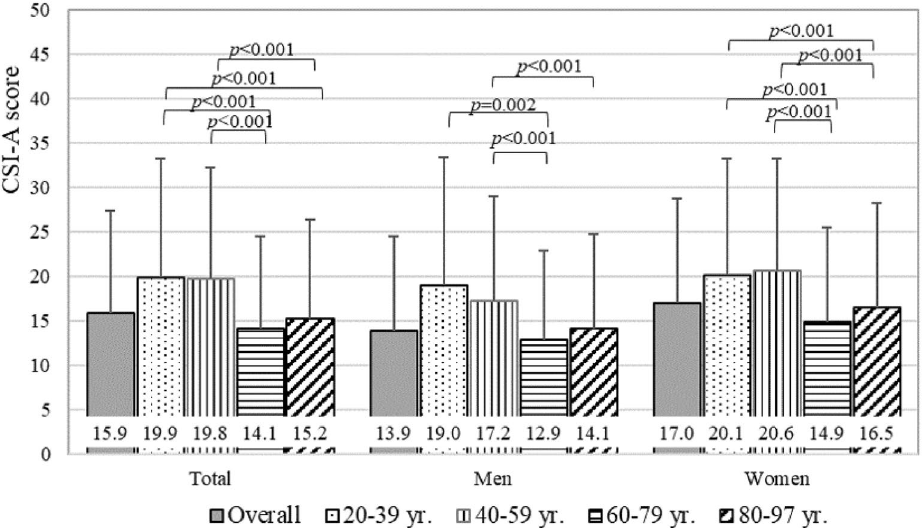
Figure 2. Average CSI-A scores by sex and age groups. CSS Central sensitization syndromes, CSI Central sensitization inventory. A Kruskal–Wallis test with the Bonferroni post-hoc test was performed among age groups. Error bars indicate the standard deviation, which based on overall and age groups are 11.5, 13.3, 12.5, 10.4, and 11.2 for total, 10.6, 14.4, 11.8, 10.0, and 10.6 for men, 11.8, 13.1, 12.6, 10.6, and 11.8 for women.